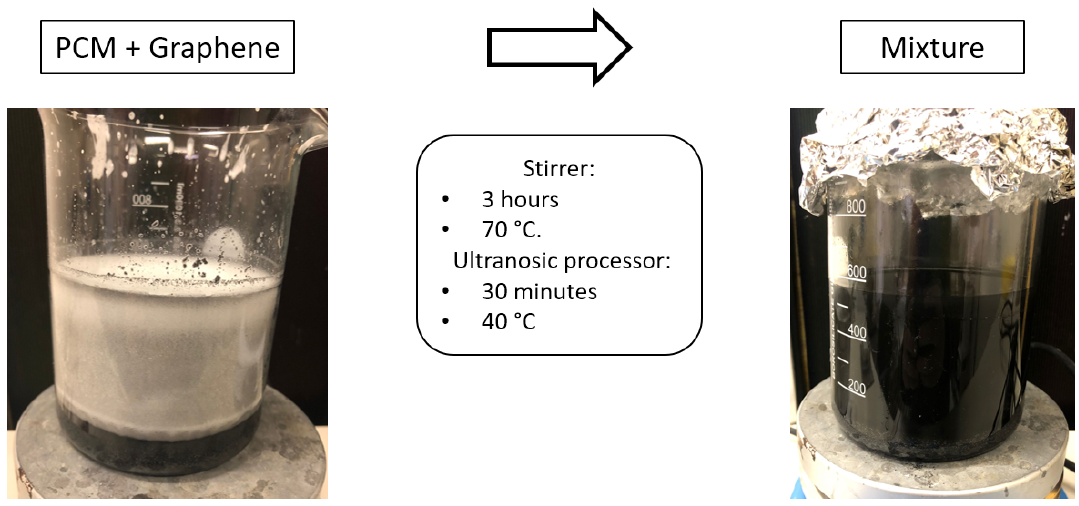
Figure 1. Preparation of the PCM/graphene mixture.